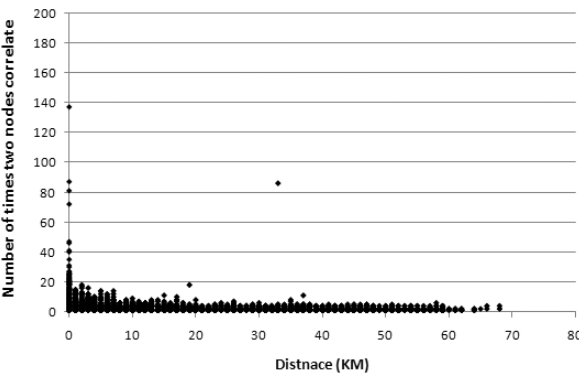
Figure 7. The relationship between the number of times two sensor nodes failed together versus the distance between them. A one hour correlation window is used.